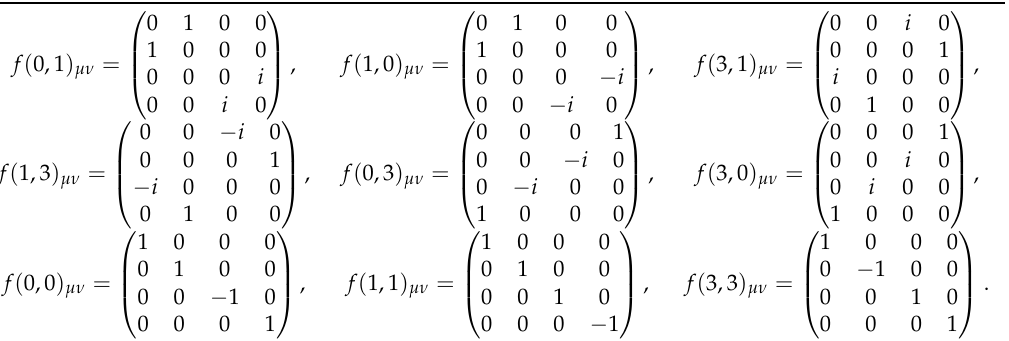
g AC (cid:48) µ g BD (cid:48) ν σ l AB C (cid:48) D (cid:48)